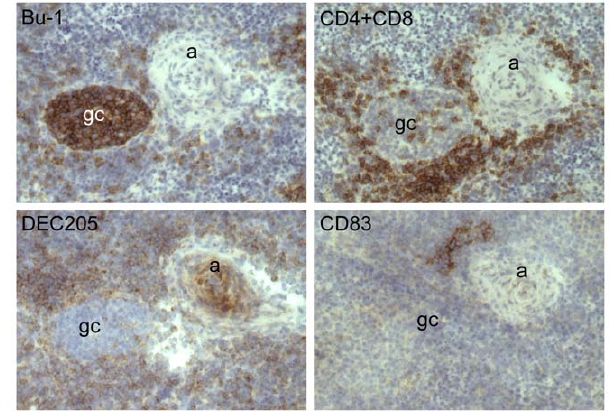
Figure 3. Localisation of cells expressing DEC205 in normal chicken spleen. The four panels show a set of serial sections of the same area from the normal spleen of a juvenile bird, stained with antibodies recognising the indicated molecules. Bu-1 reveals B cells and CD4 a subset of T cells. KUL01 is a marker for monocyte/macrophage lineage cells. DEC205 is detected using the antibody FG9. The dotted curves indicate the approximate outlines of the same peri-ellipsoid lymphocyte sheaths (pe) in each section. Other labelled features are ellipsoid (e), aterioles (a) and peri-arteriolar lymphocyte sheath (pa) [12].